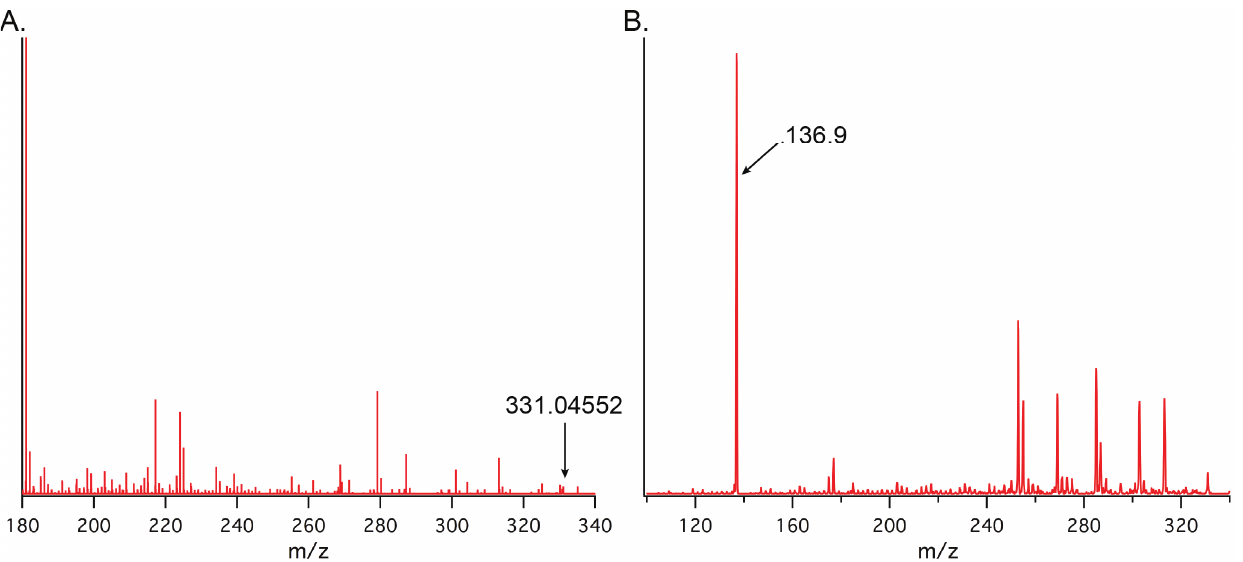
Figure 9. High resolution MS ( A ) and MS/MS ( B ) spectra of 2',3'-cIMP extracted from rat brain. Authentic 2',3'-cIMP: 331.04525; extracted: 331.04552. Authentic 2',3'-cIMP [BH 2 ] + : 136.9; extracted: